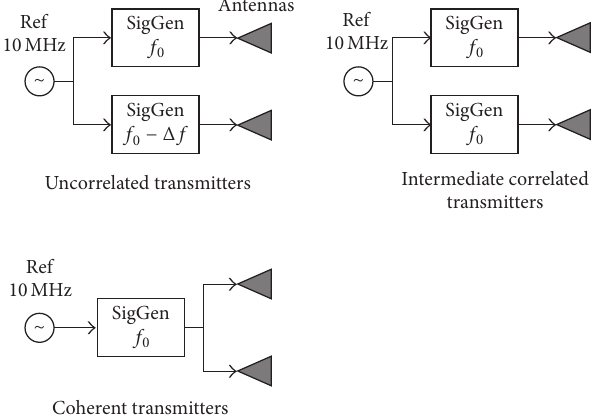
Figure 6: Generation of uncorrelated, intermediate correlated, and coherent transmitters. An integral number of periods of the uncorrelated signals fit exactly in the acquisition interval. The frequency 𝑓 0 was about 3 GHz and Δ𝑓 about 0.4 MHz.